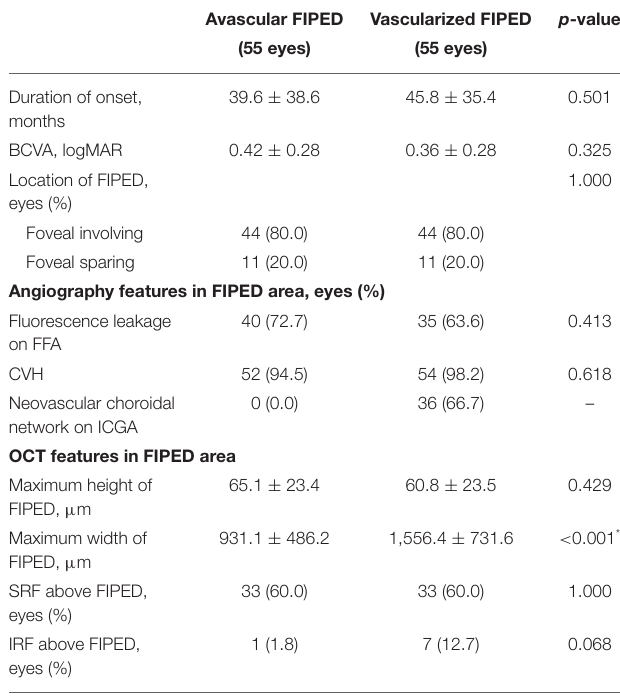
TABLE 2 | Comparison between avascular and vascularized FIPEDs in chronic Total or mean